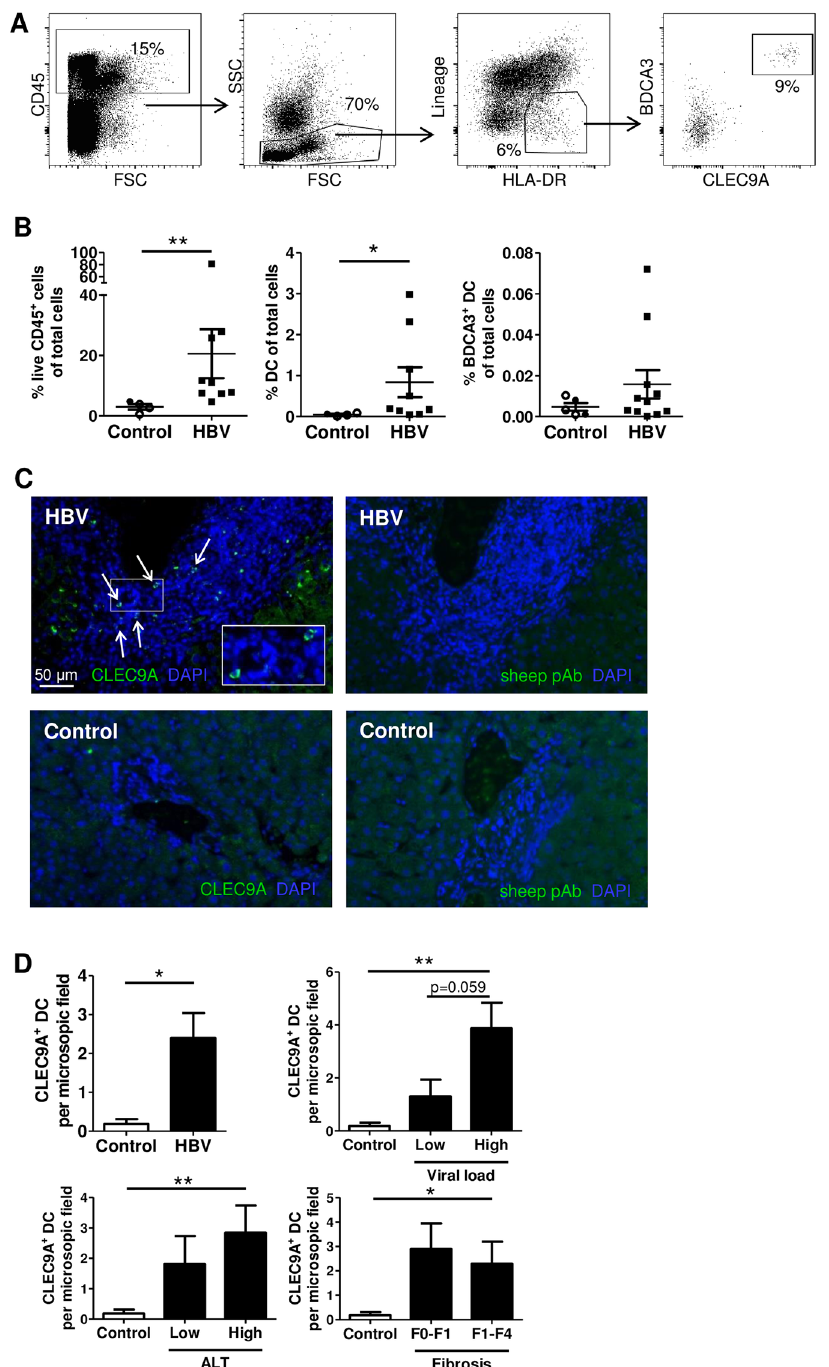
Fig 1. Quantification of intrahepatic BDCA3 + DCs from HBV patients and controls. (A-B) Liver cells were isolated from HBV patients and controls. The DC population was identified as CD45 + Lineage - HLA-DR + mononuclear cells, within which BDCA3 + CLEC9A + DCs were detected. (A) Representative flow cytometry plots and (B) the percentage CD45 + cells of total cells (control n = 4, HBV n = 9), percentage DCs of total cells (control n = 4, HBV n = 9) and percentage BDCA3 + DCs of total cells (control n = 5, HBV n = 11) in livers of controls and HBV patients. Indicated are the mean percentage and SEM. Open dots represent cells from donor livers and filled dots represent cells from peri-tumor liver tissue. ** p < 0.01 by Mann-Whitney test. (C-D) FFPE sections of HBV-infected and control livers were stained with anti-CLEC9A Abs or non-specific sheep